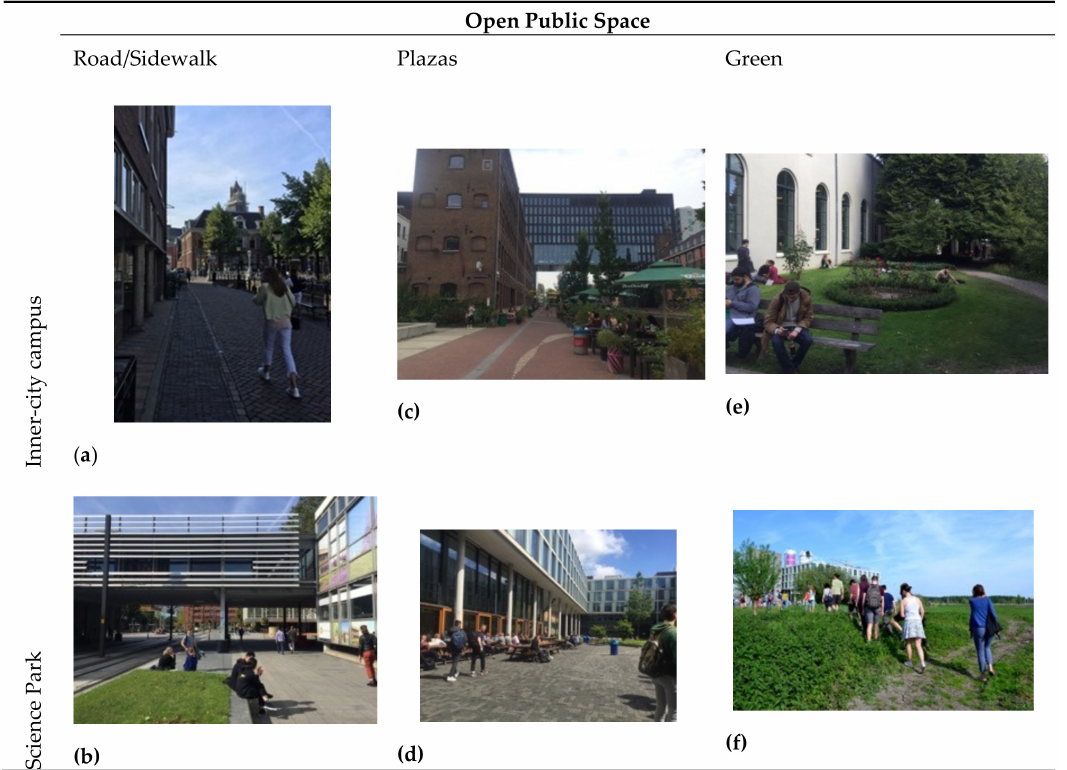
Figure 15. Open public spaces at inner-city campuses and SPs: ( a ) Drift street (Utrecht centre); ( b ) USP Heidelberglaan; ( c ) RI; ( d ) Outdoor area at ASP Faculty of Science; ( e ) Garden of the buildings on Drift street; ( f ) ASP Anna’s Tuin